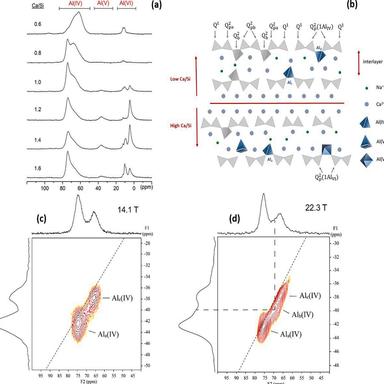
(a): 27Al MAS NMR spectra (14.09 T) for the C-(A)-S-H with Ca/Si ratio = 0.6–1.6, Al/Si ratio = 0.10 cured for three months at 1.0 M of NaOH solution. The Al (IV), Al (V), and Al (VI) regions have been indicated. (b) Schematic illustration of the proposed C-(A)-S-H structure with low Ca/Si ratio on defect tobermorite model and the 23Na, 27Al and 29Si MAS NMR experiments along with the proposed assignments for the different silicate sites and aluminum sites Ala(IV): charge balanced by Na+ and H+; Alc(IV) ch